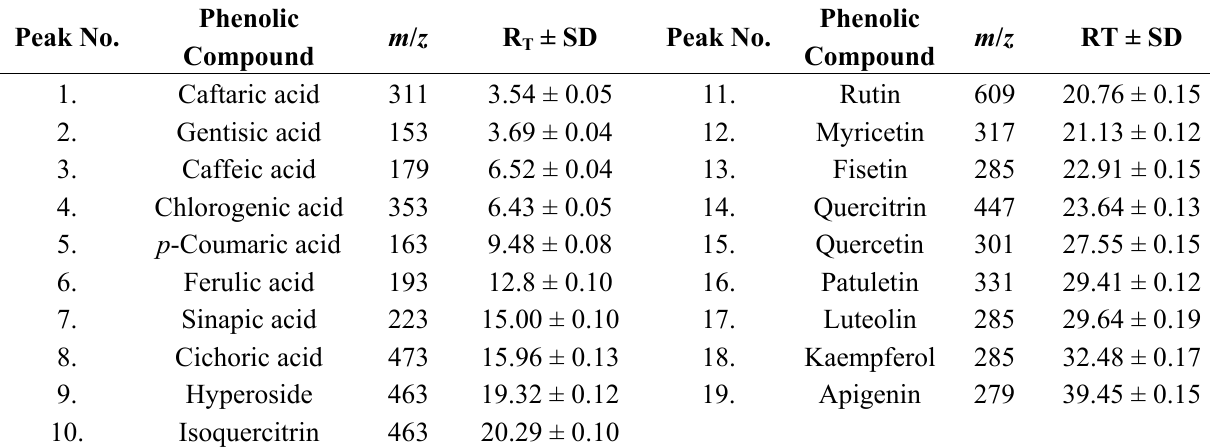
) of polyphenolic compounds T